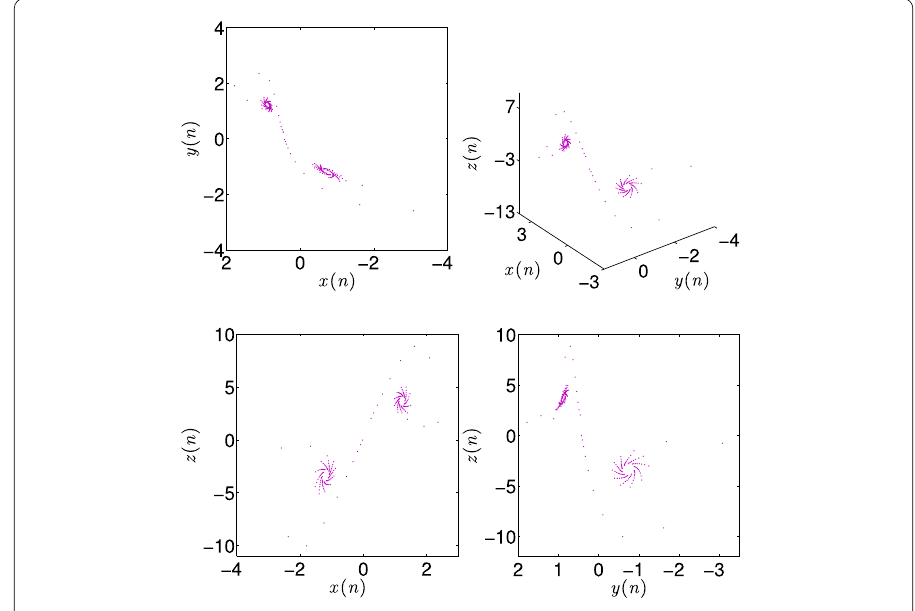
Figure 16 Phase space portraits of the fractional-order Wang map for υ = 0.97